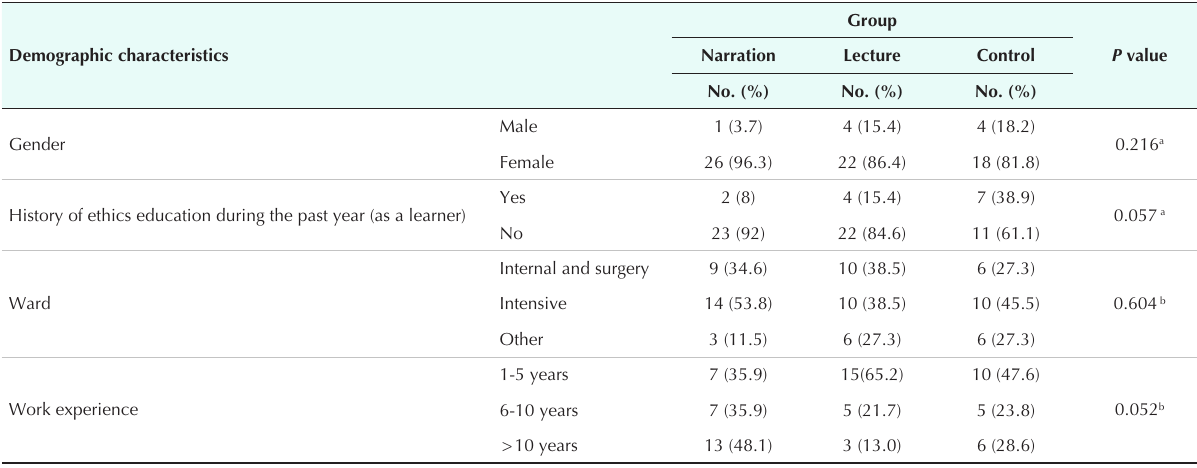
Table 1. Comparison of participant demographic characteristics in three groups of narration, lecture, and control